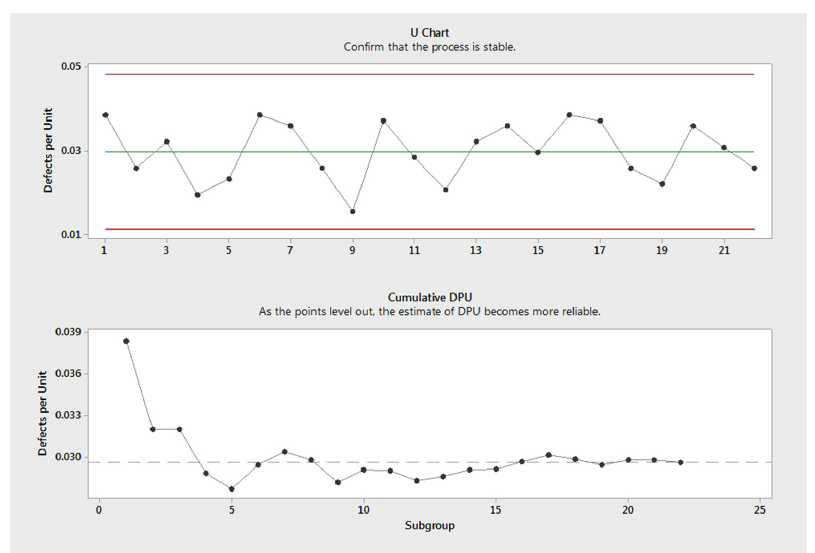
Figure 9. Diagnostic report—Poisson capacity analysis for scrap door.